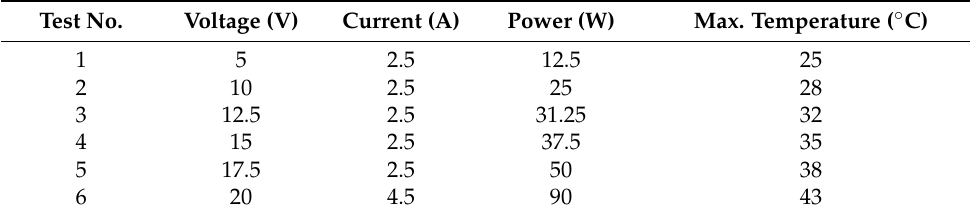
Table 4. Results from heating tests for flat